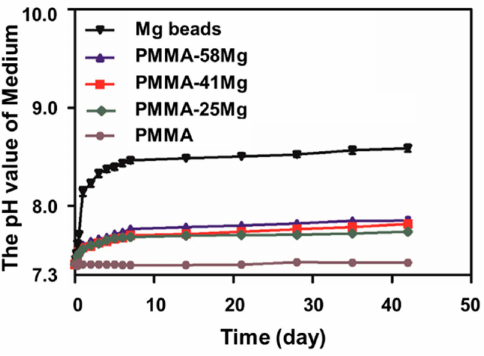
Figure 7. The changes of pH value of SBF medium containing Mg beads, PMMA, PMMA–25Mg, PMMA–41Mg, and PMMA–58Mg bone